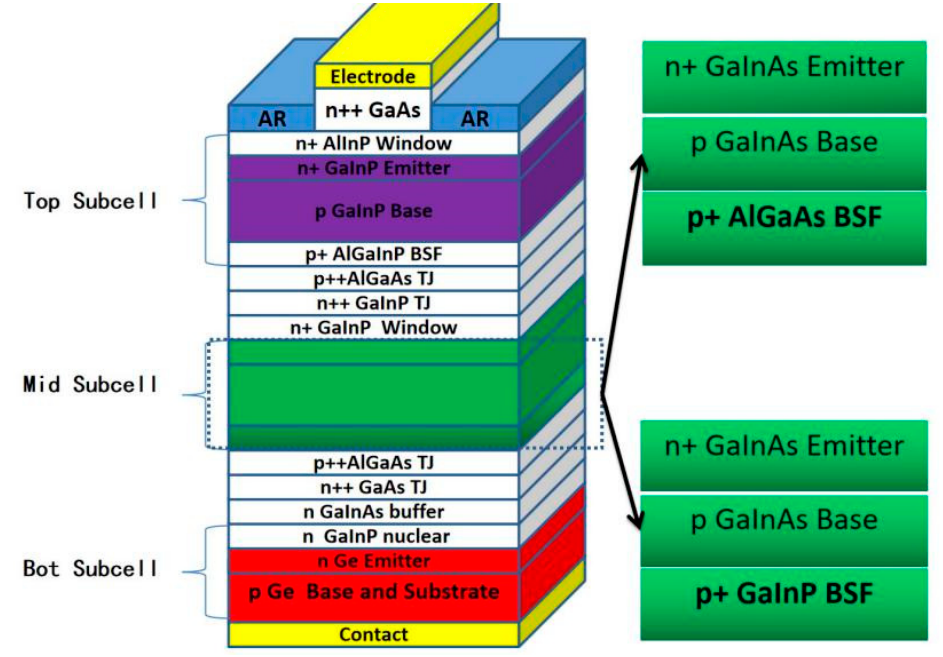
Figure 1. Schematic structure for solar cells with an AlGaAs back-surface field (BSF) or a GaInP BSF in the middle subcell, respectively.